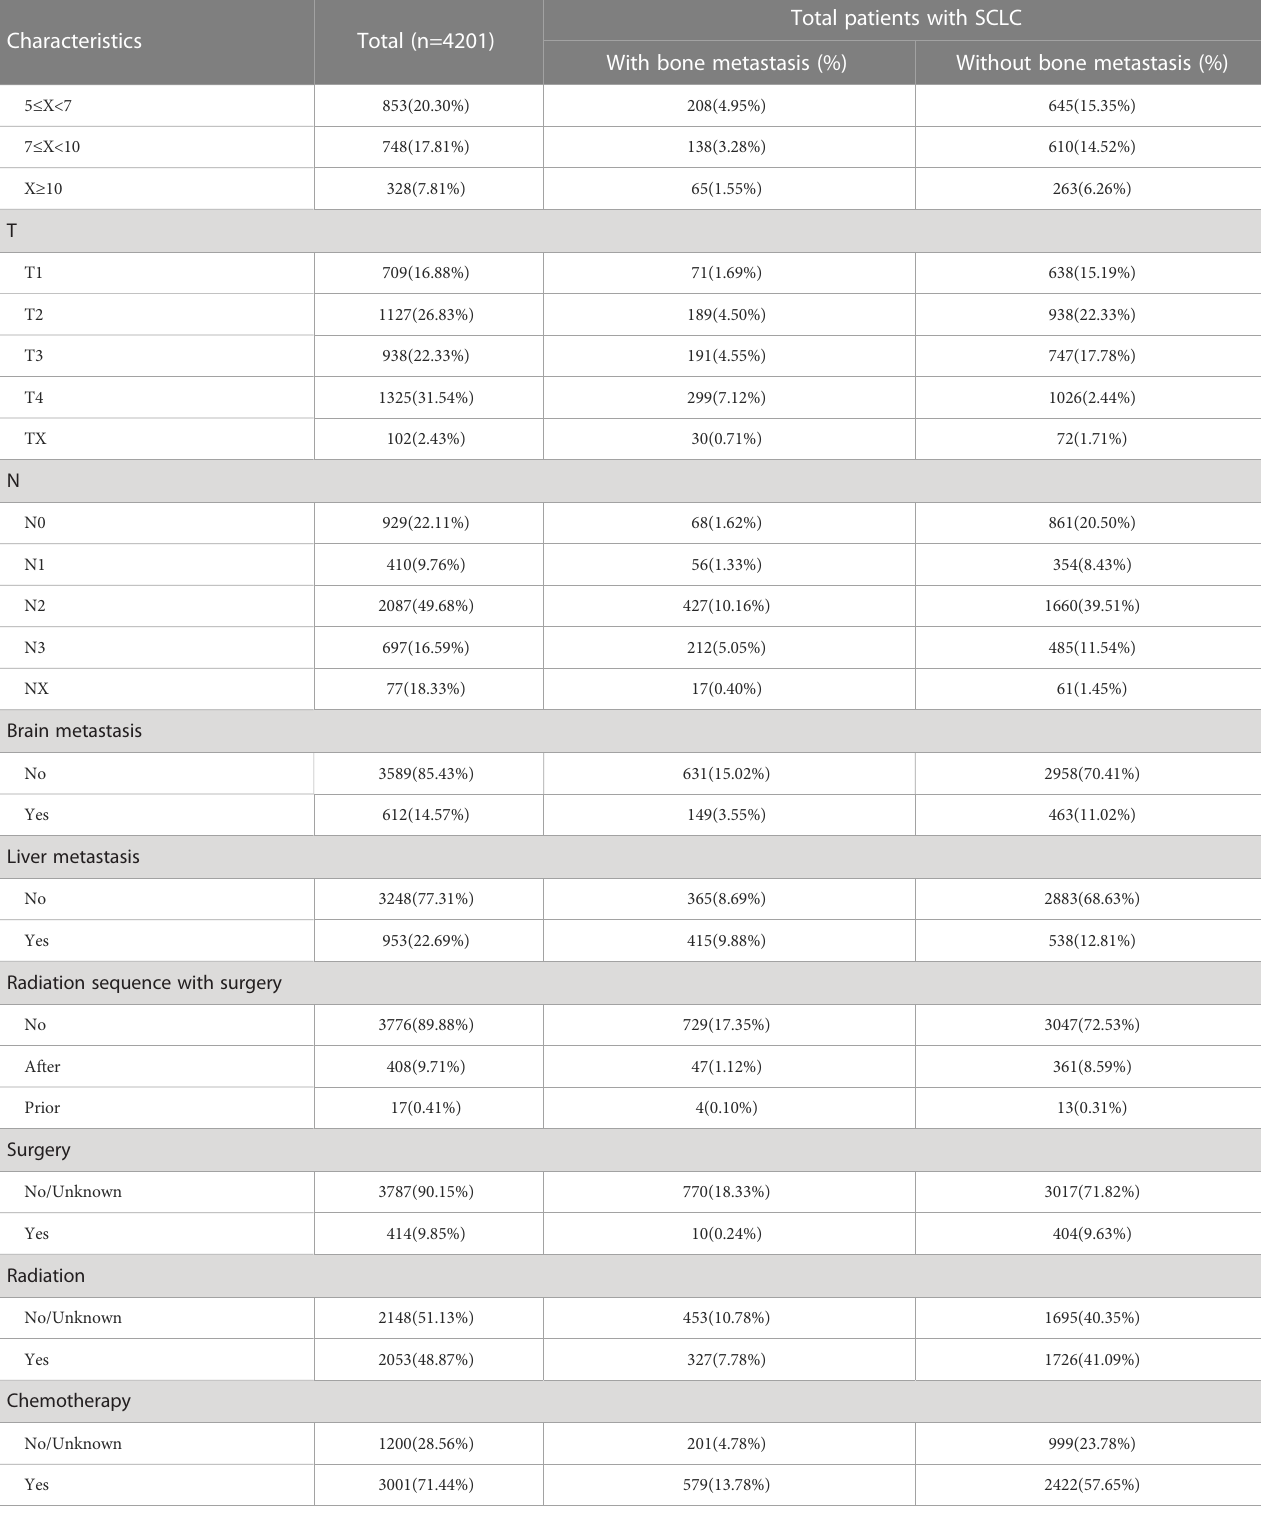
Based on recommendations for tumor nodule metastasis